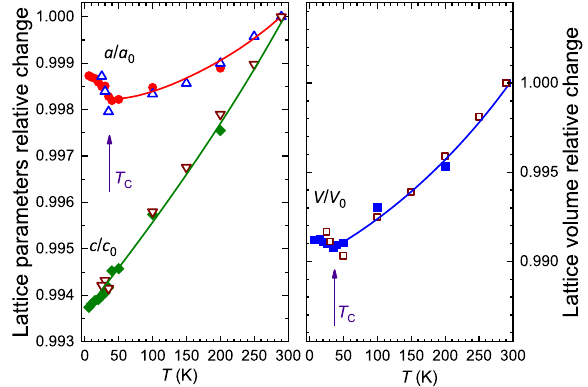
Fig. 2 The temperature dependences of the lattice parameters of CrBr 3 . The temperature dependences of the lattice parameters and volume obtained from neutron (solid symbols) and X-ray diffraction (open symbols) measurements and normalized to the ambient temperature values. The lines are guides to eyes